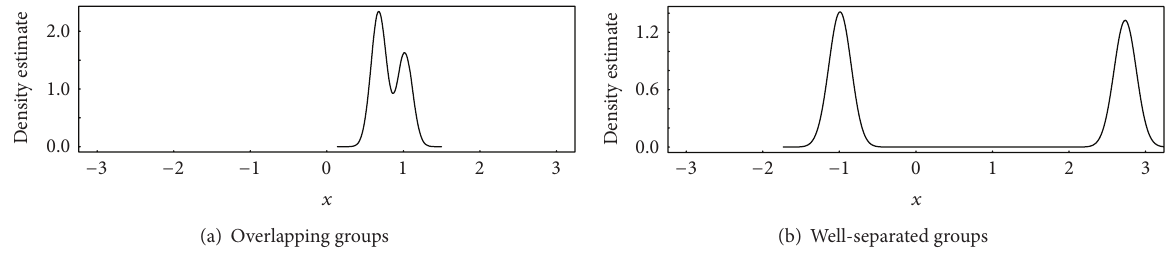
Figure 5: Overlapping (a) and well-separated (b) groups.